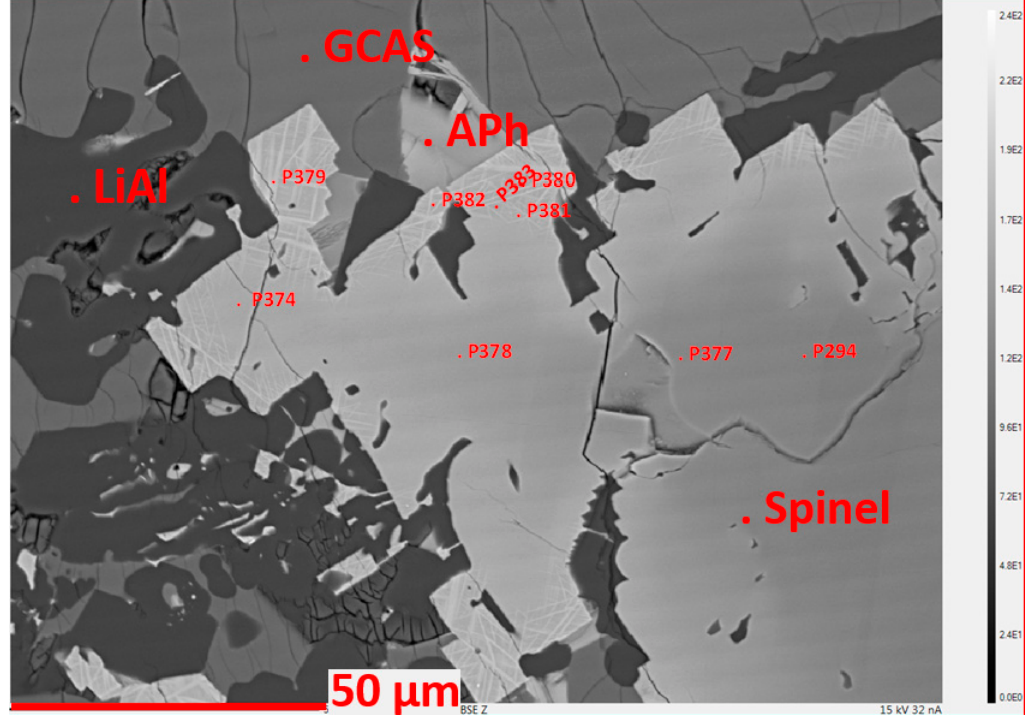
Figure 5. Electron micrograph (BSE(Z)) of the solidified melt. Light grey grain: spinel; dark gray sections, and dendrites: LiAl, surrounded by Ca-alumosilicate (GCAS, light grey sections); amorphous phases (APh): amorphous grain with unusual elements (K, Ba, Ti): contamination; black: pores or preparation damage. The chemical analysis of the points marked in red (P294–P383) is presented in Table 3. Table 3. Elemental concentrations (wt.%) at the locations depicted in Figure 5, sorted in ascending order according to the Al concentration. For a close-up of the lamellae region, see Appendix C. The distance from the lamellae region points to the nearest rim is given. Regarding the point scans, a virtual line is drawn through all points to the left rim. The distances are given from each point to the intersection of this line with the rim. Location Lamellae Region Point Scan No.